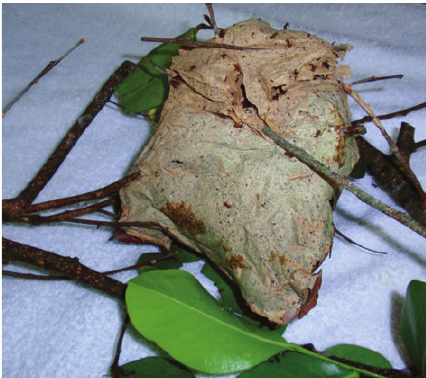
Figure 4: The silk nest of the weaver ant host Camponotus sp. aff. textor . Photo: G. P´erez-Lachaud.